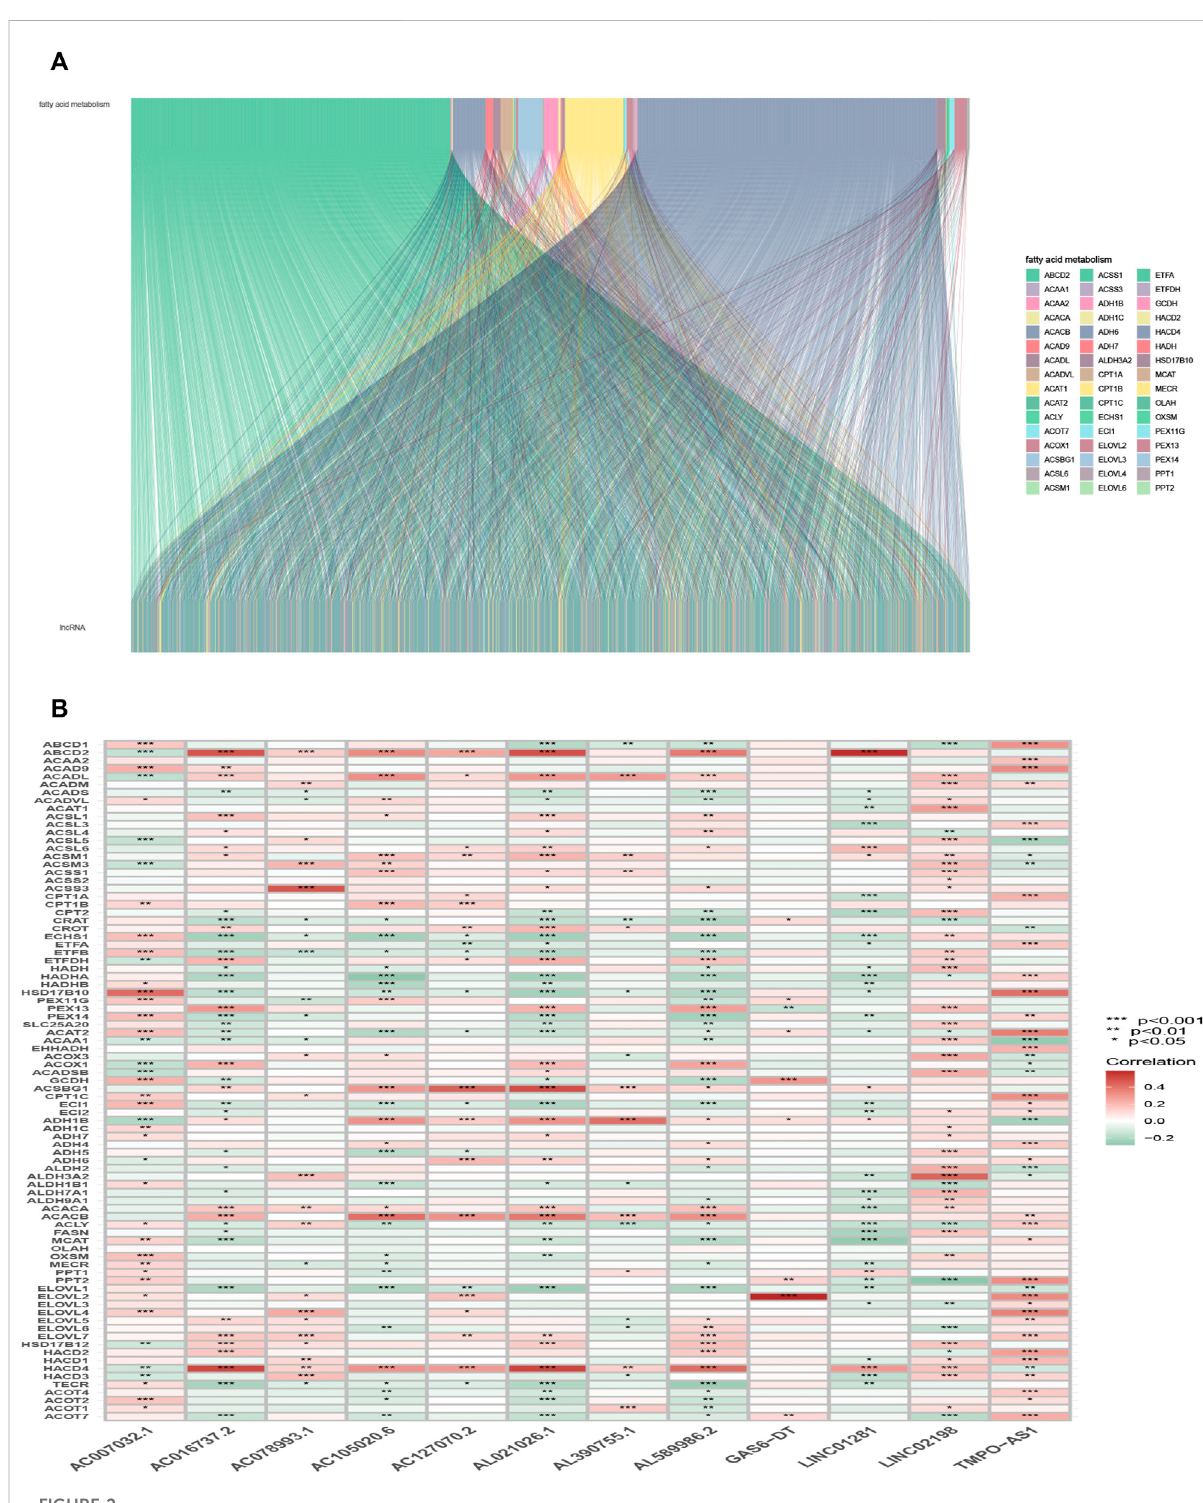
FIGURE 2 Selection of FAM-related lncRNAs in LUAD patients. (A) Sankey relation diagram for target lncRNAs. (B) Heatmap of the correlation between FAM-related genes and the 12 prognostic FAM-related lncRNAs in TCGA entire